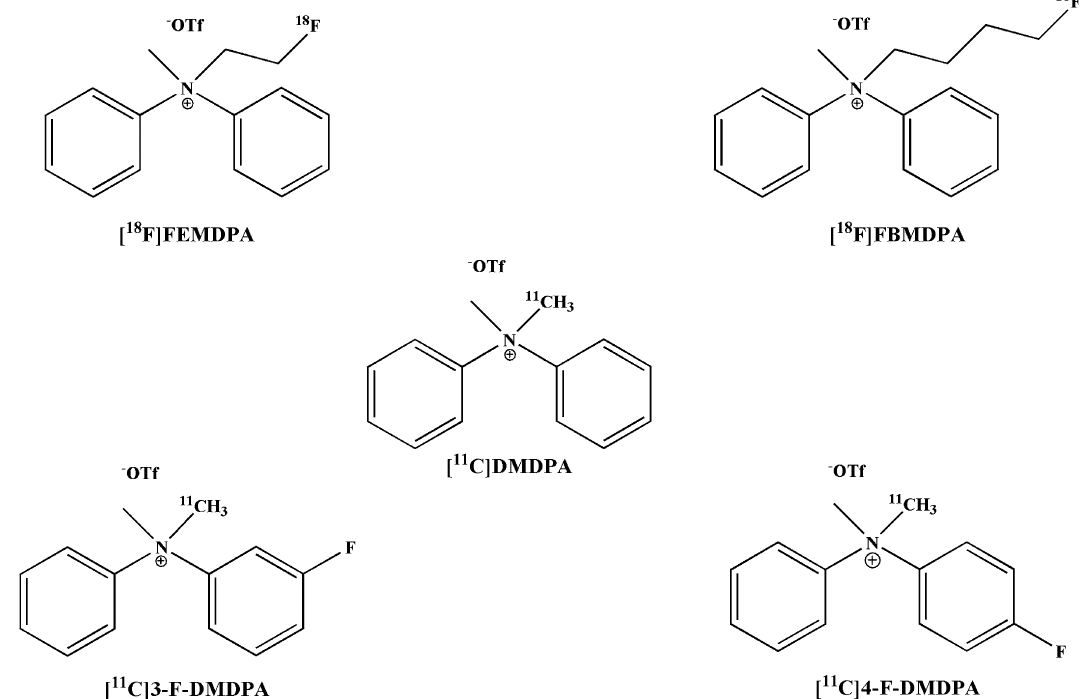
Figure 1. Chemical structures of 11 C-dimethyl diphenylammonium trifluoromethanesulfonate ([ 11 C]